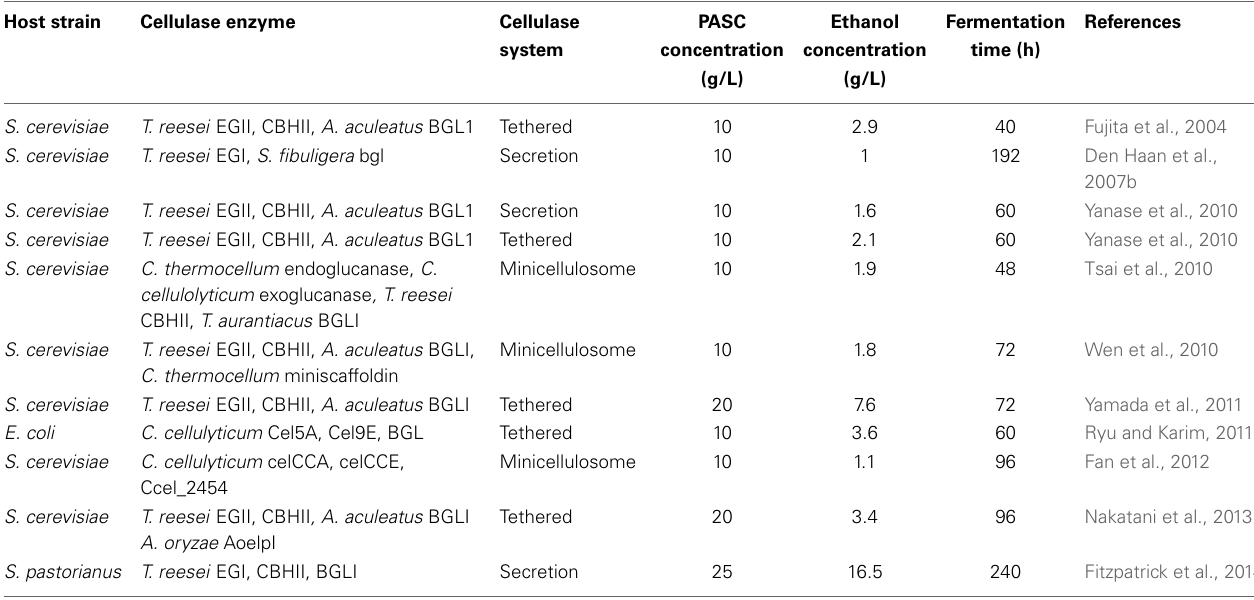
Table 1 | Ethanol production from PASC by recombinant yeast strains expressing cellulases. Host strain